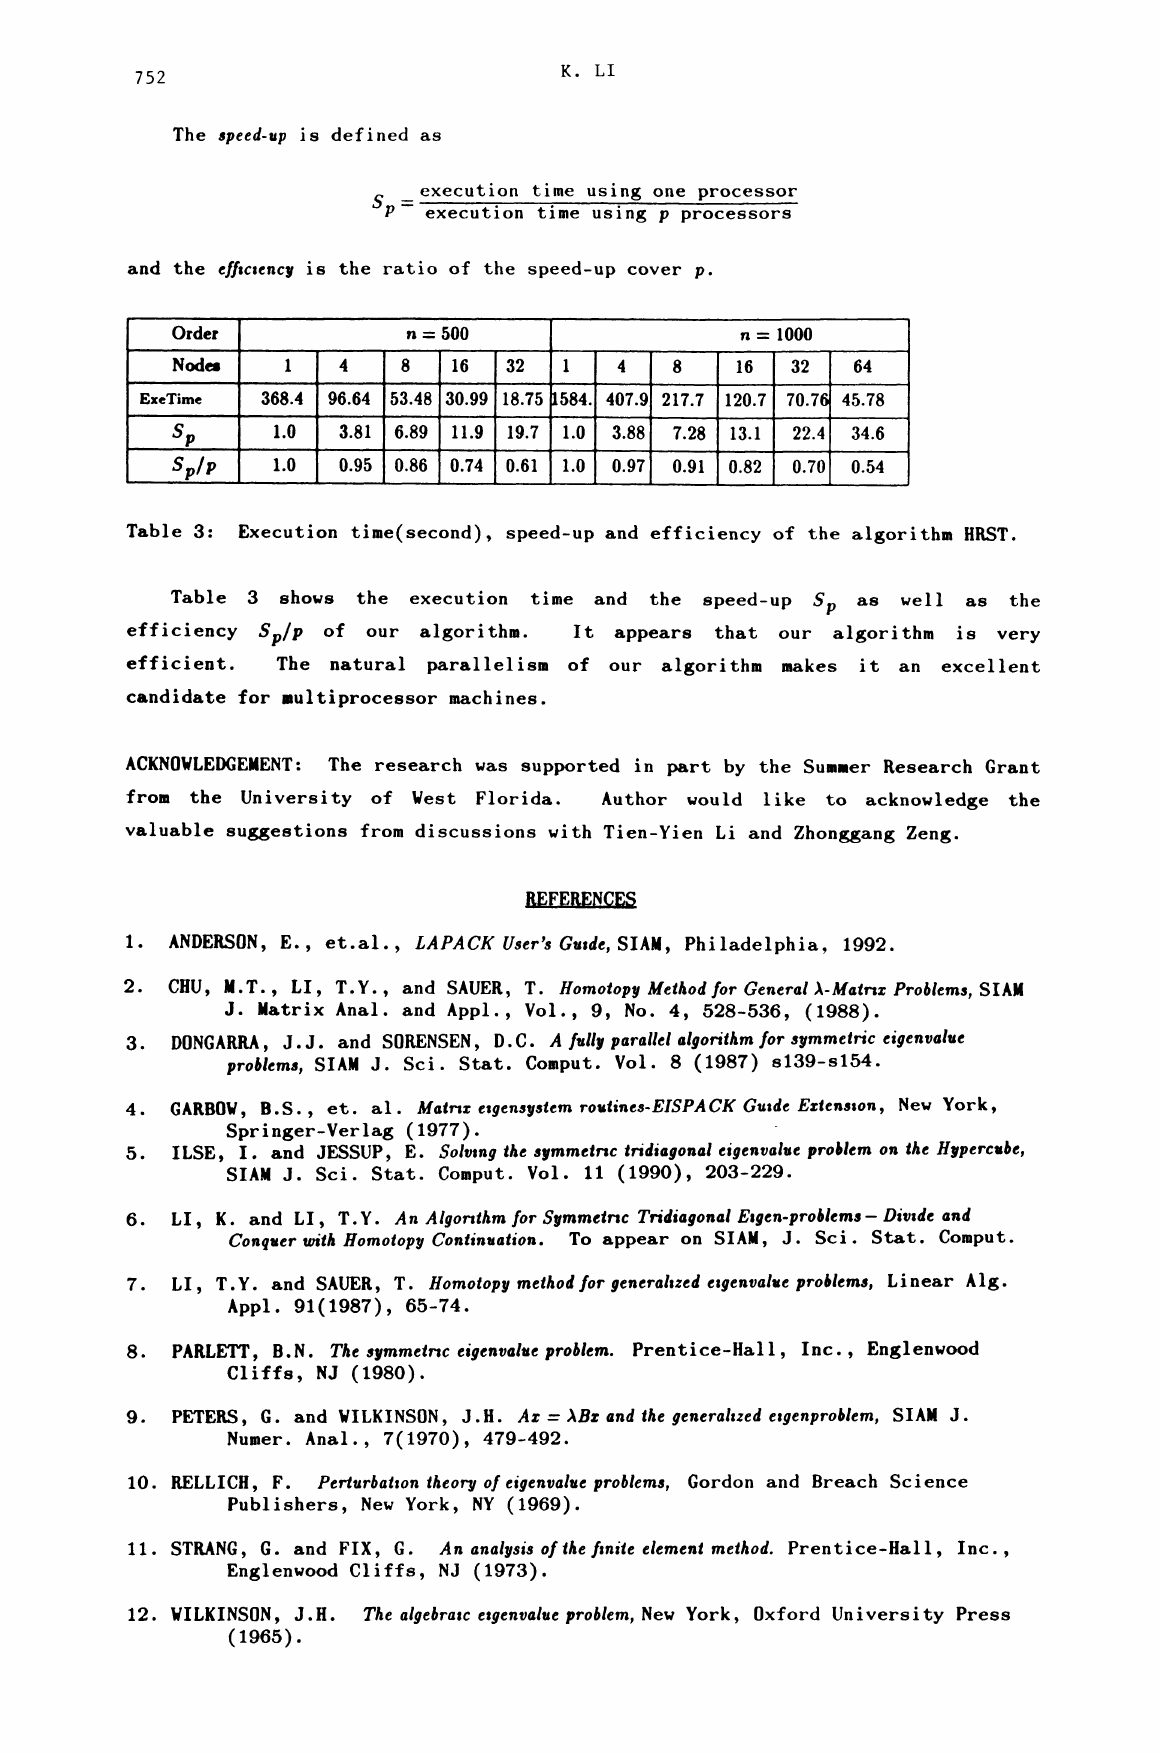
Execution time(second), speed-up and efficiency of the algorithm